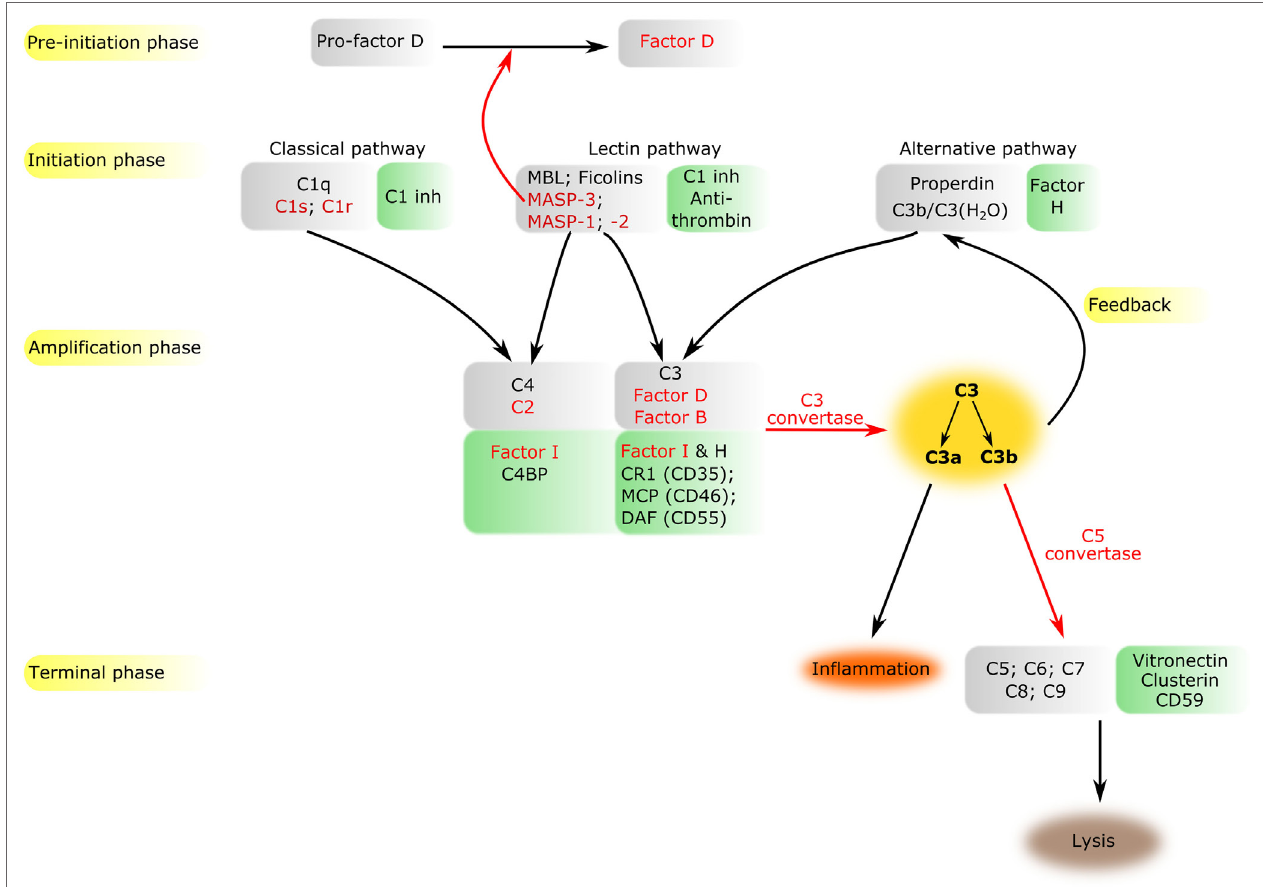
FiGURe 1 | Overview of the complement system. The components of all activation phases are listed in gray boxes, while their inhibitors in green boxes nearby. Serine proteases are indicated by red letters. Black arrows indicate the direction of the cascade. Certain enzymatic cleavages are emphasized by red arrows. The three activation routes merge at the cleavage of C3 highlighted by dark yellow background.